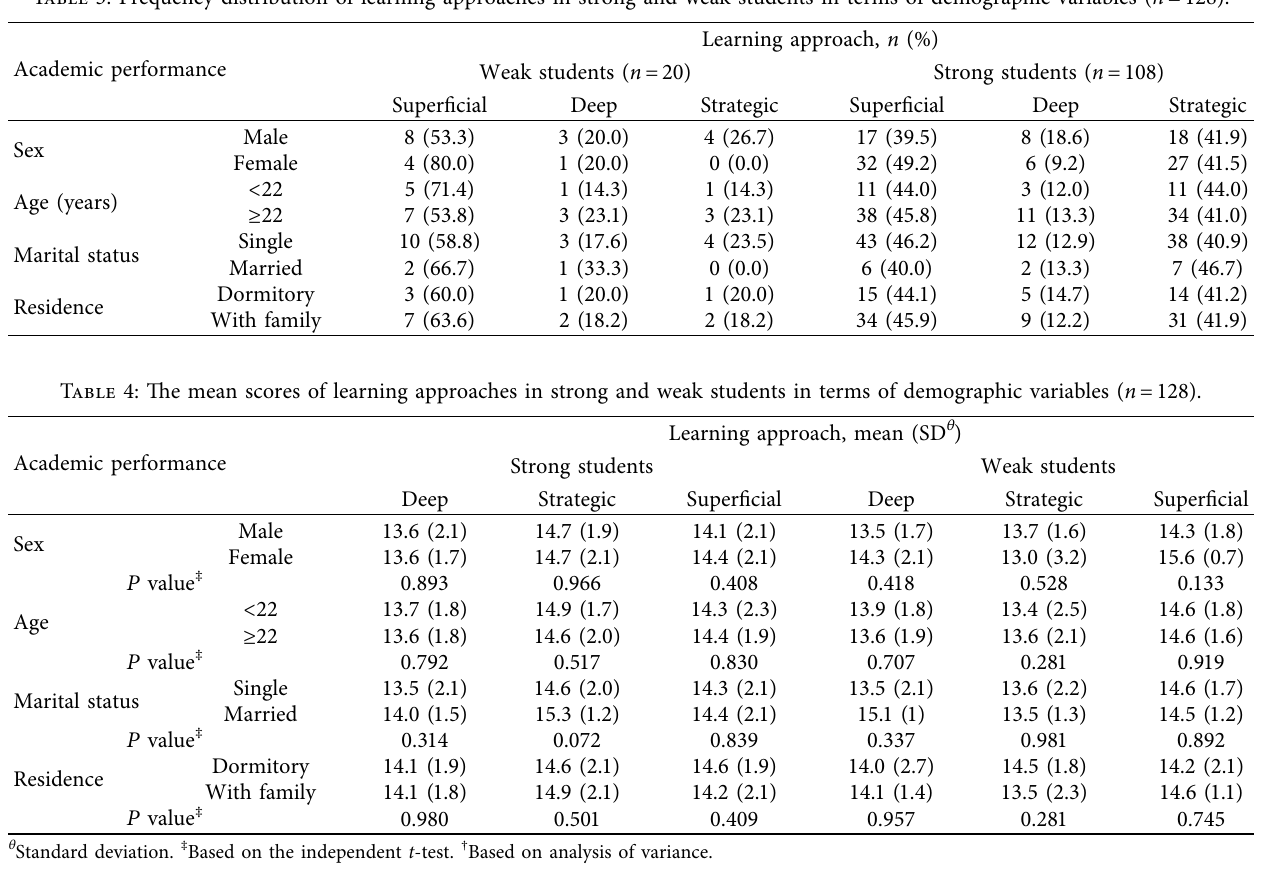
Table 3: Frequency distribution of learning approaches in strong and weak students in terms of demographic variables ( n � 128). Academic performance